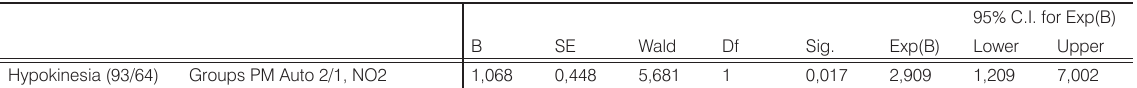
Table 7. Odds ratio for AMI in people working in a hypokinetic state in days with concentrations of FPM the days with FPM10 below 0.01 µg/m 3 at the measuring point of “Ian Palach St.”, by controlling the concentrations of nitrogen oxide.